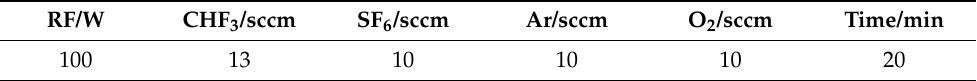
Table 2. Essential parameters of RIE for transferring nano/micro-texture pattern to Si 3 N 4 layer. RF/W